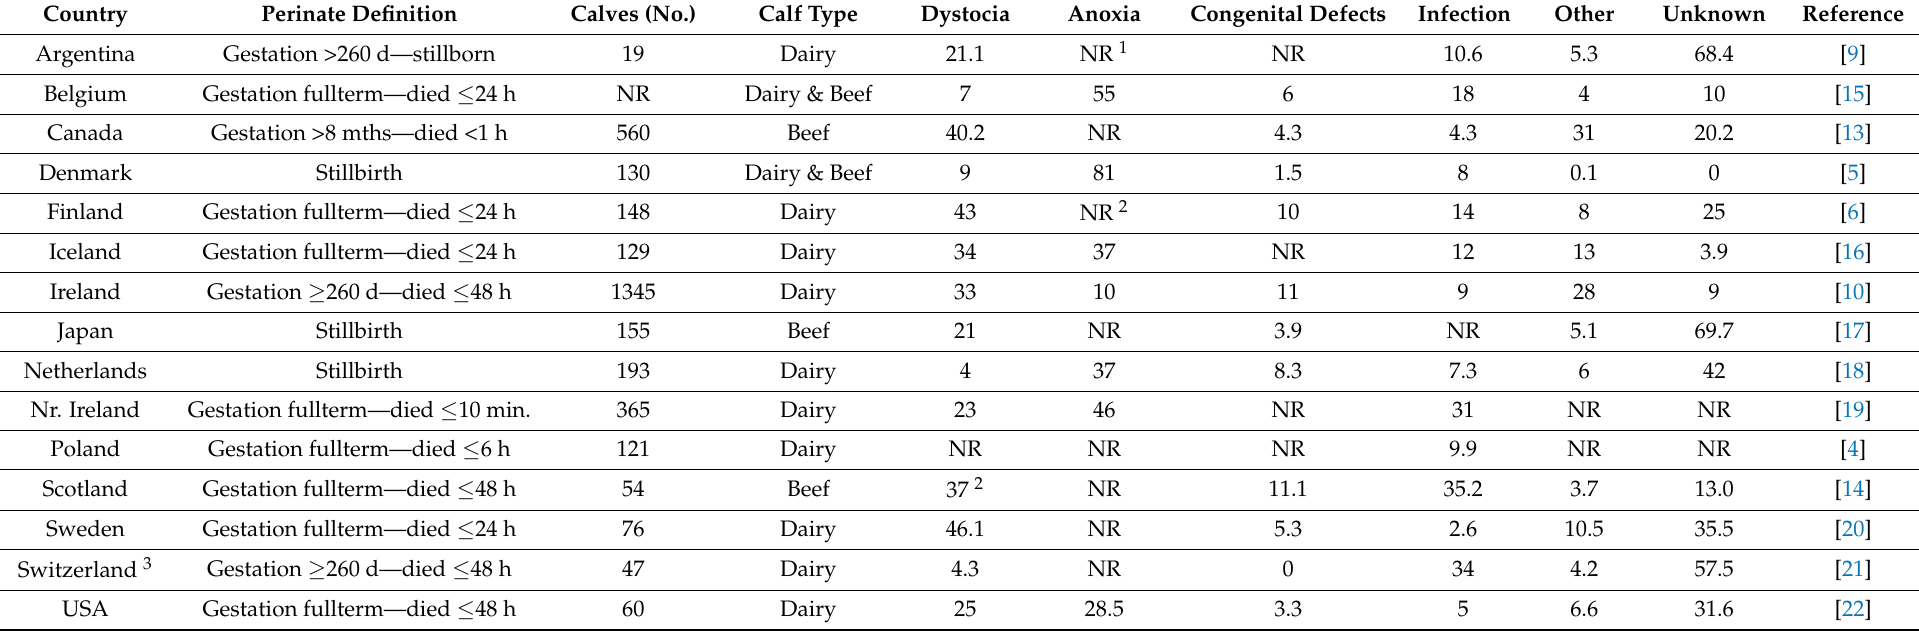
Table 1. Necropsy-diagnosed causes-of-death (%) for calves dying in the perinatal period (0–48 h)